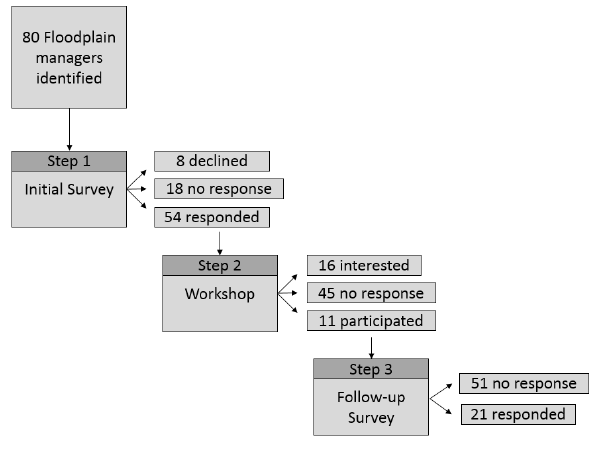
Fig. 2 . Our objective to identify management priorities